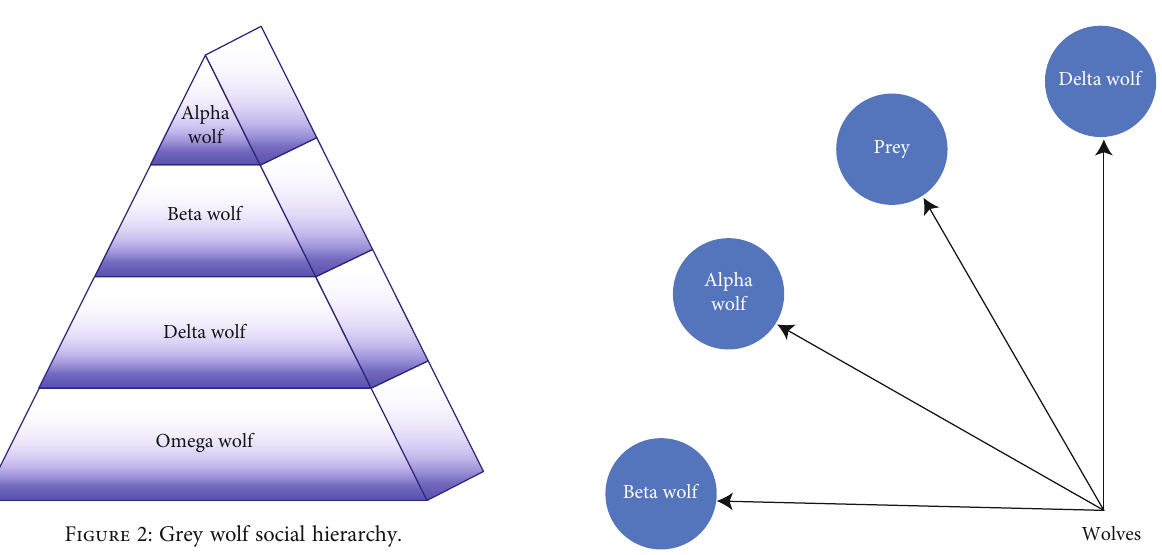
Figure 3: Schematic diagram of grey wolf location update.